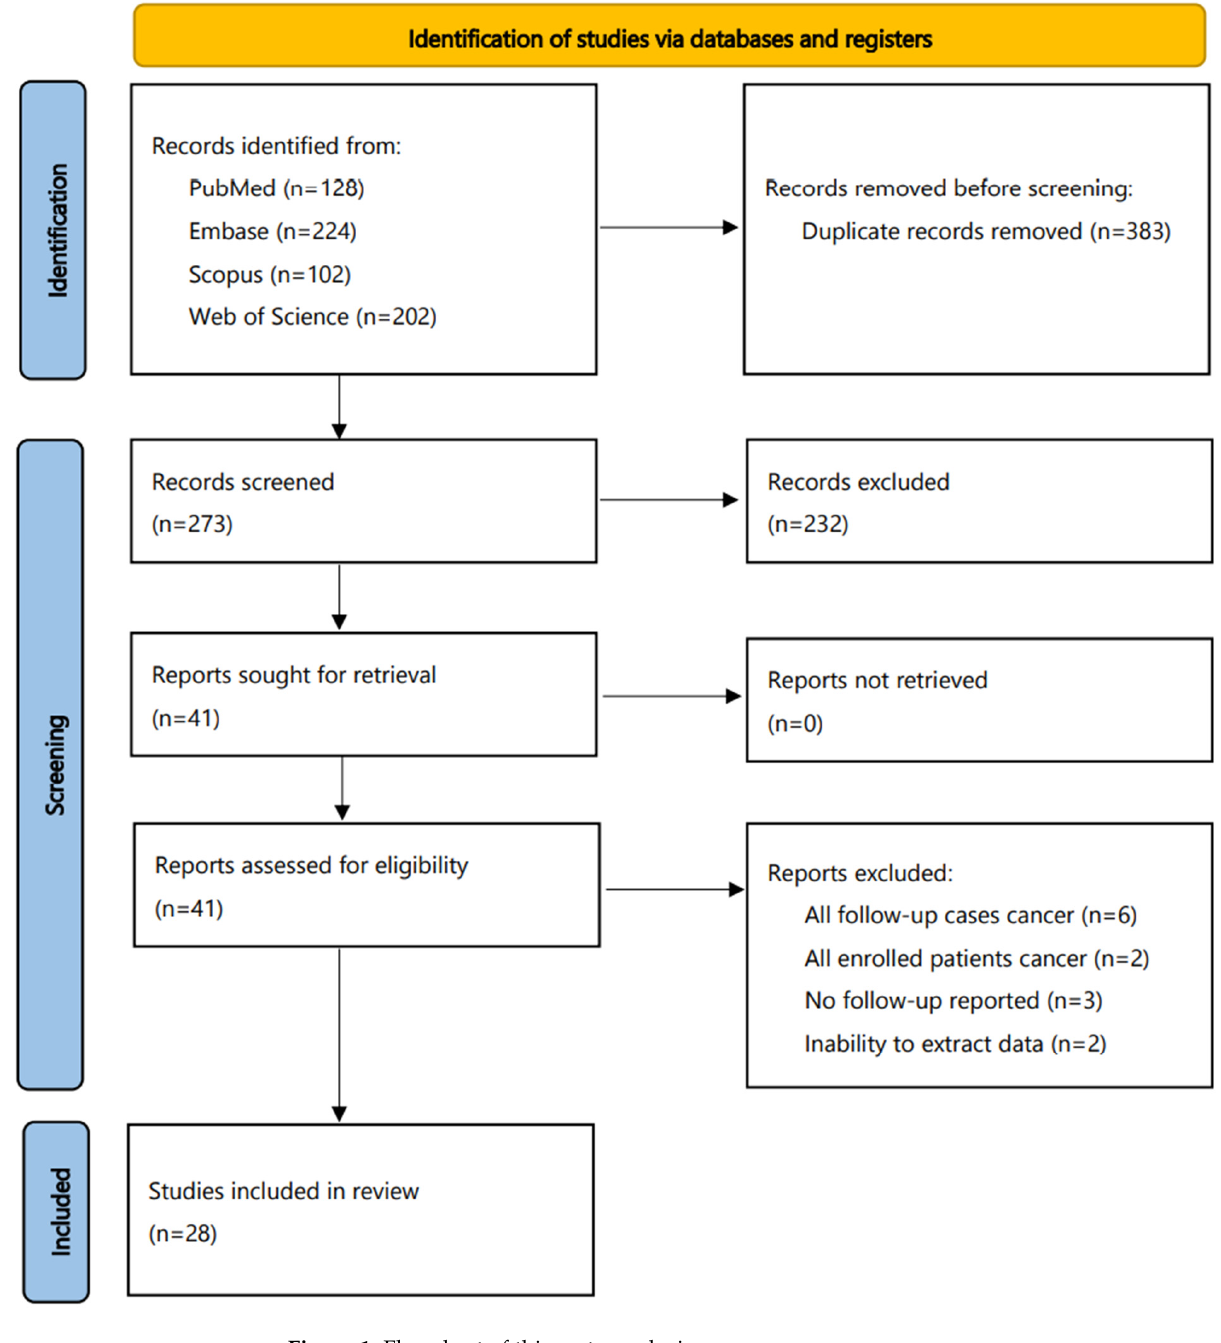
Figure 1. Flowchart of this